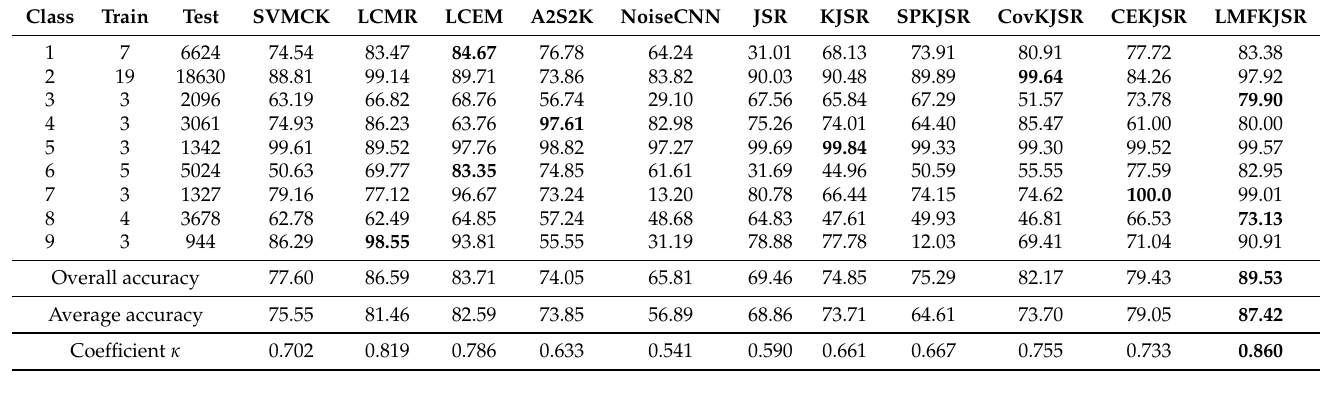
Table 2. Classification results on the UP data set with 0.1% labeled training samples (50 training samples). The bold values indicate the highest accuracy among all methods.